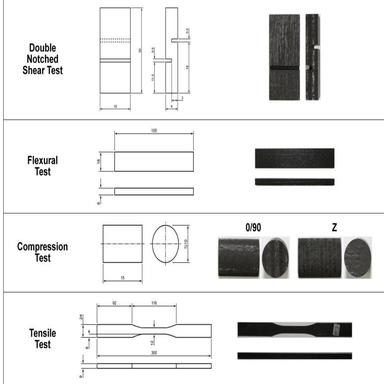
Shapes and dimension of the samples for mechanical tests.